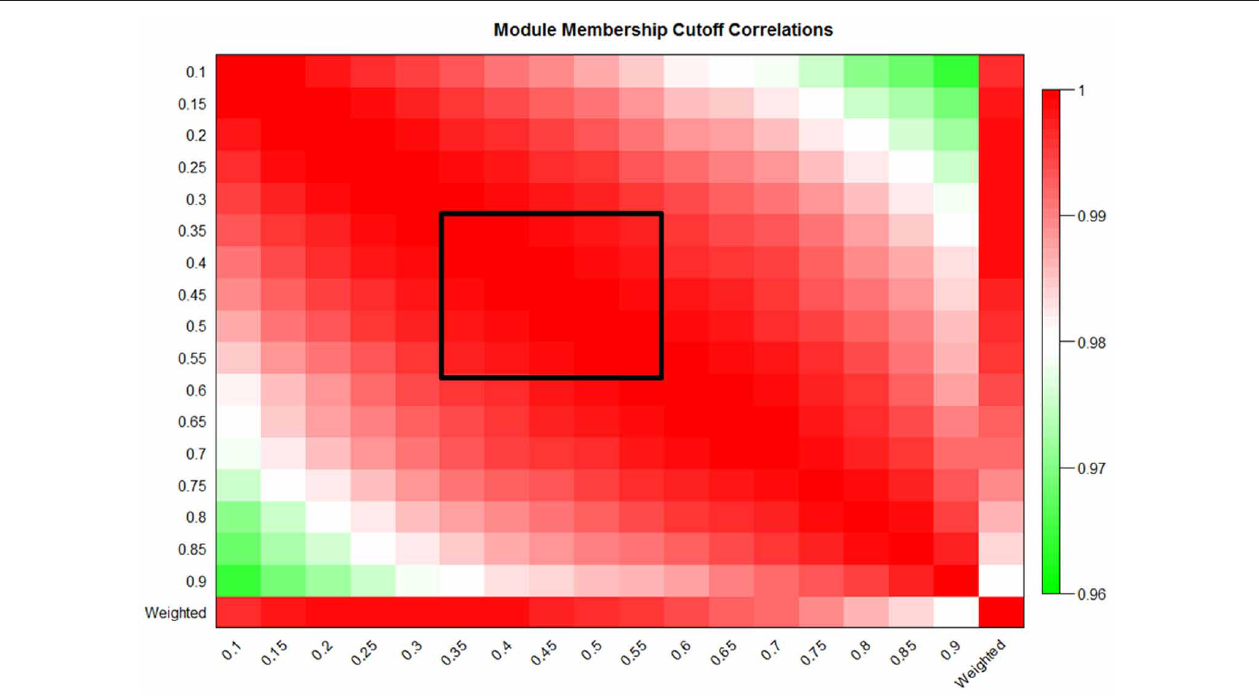
FIGURE 4 | Eigengene values are preserved over a large range of MM cutoffs in MICA. Eigengene correlations at 5% cutoffs from 10% to 90% MM and also the weighted eigengene for the macrophage dataset.